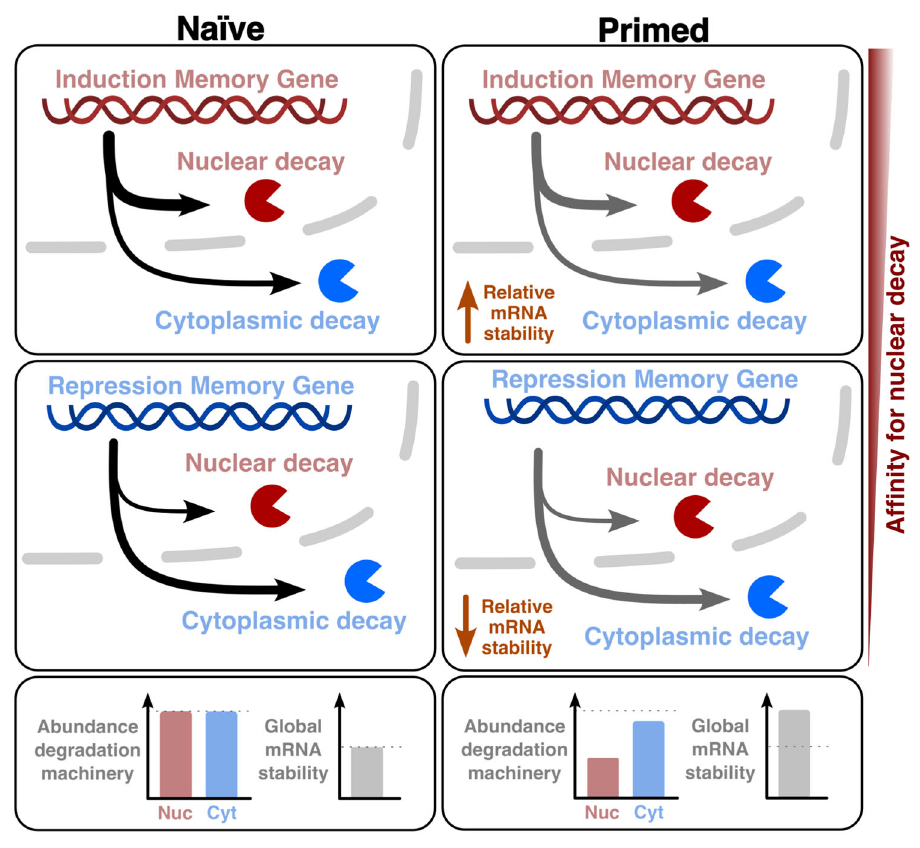
Fig. 6 | Working model for the role of mRNA stability in transcriptional memory. Induction memory and repression memory genes present different intrinsic susceptibilities to nuclear mRNA decay. After galactose priming, the abundance of nuclear degradation machinery decreases. Thus, although there is a